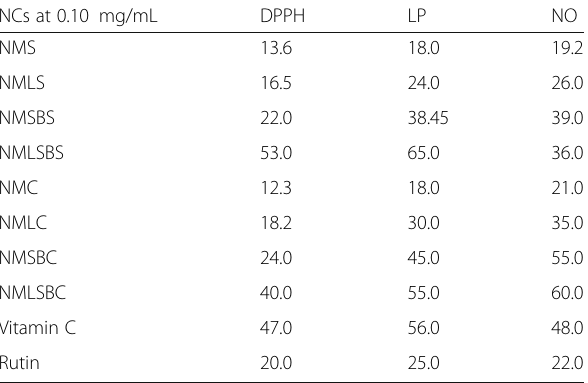
Table 5 Neem cosmetics scavenging effects on different radicals at 0.10 mg/mL